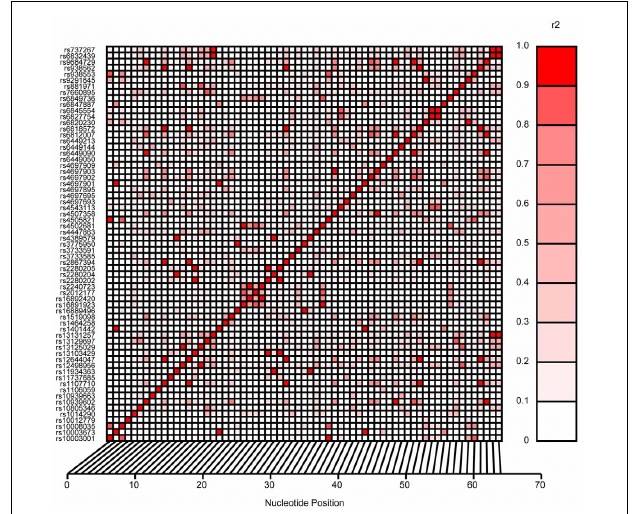
FIGURE 1 | Linkage disequilibrium pattern of SLC2A9 SNPs investigated in this study.